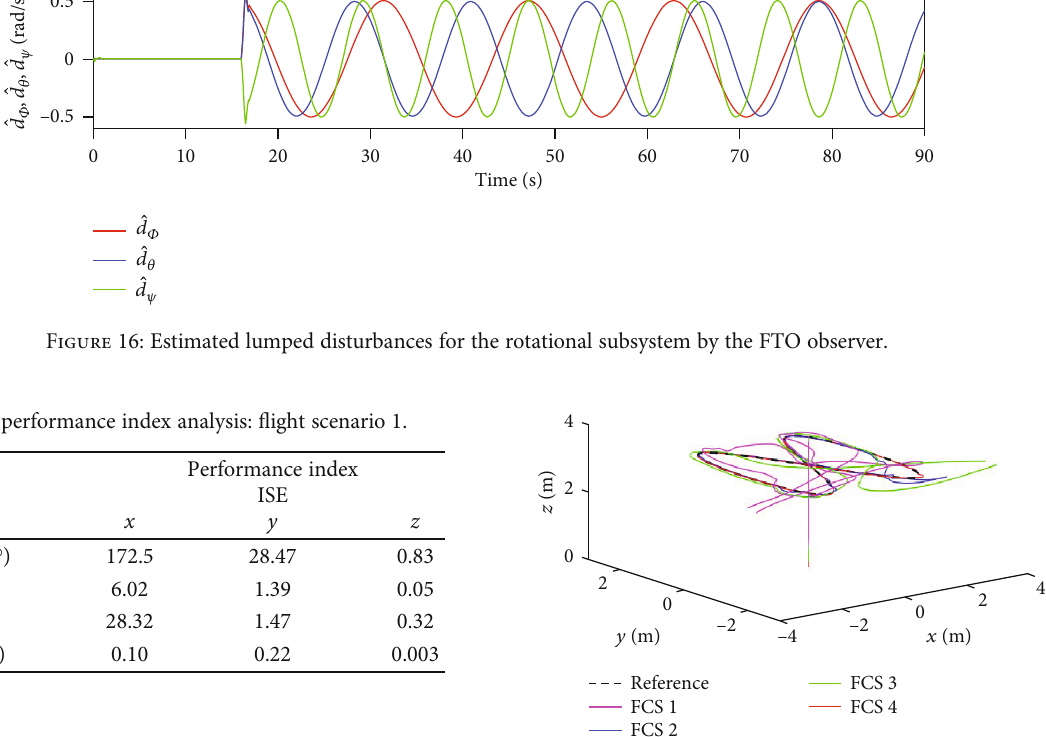
Table 4: IADU performance index for chattering analysis. Control strategy